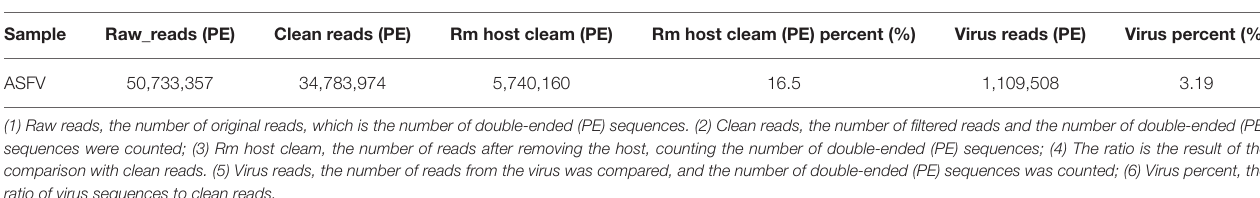
TABLE 1 | Removal of host sequence and virus sequence